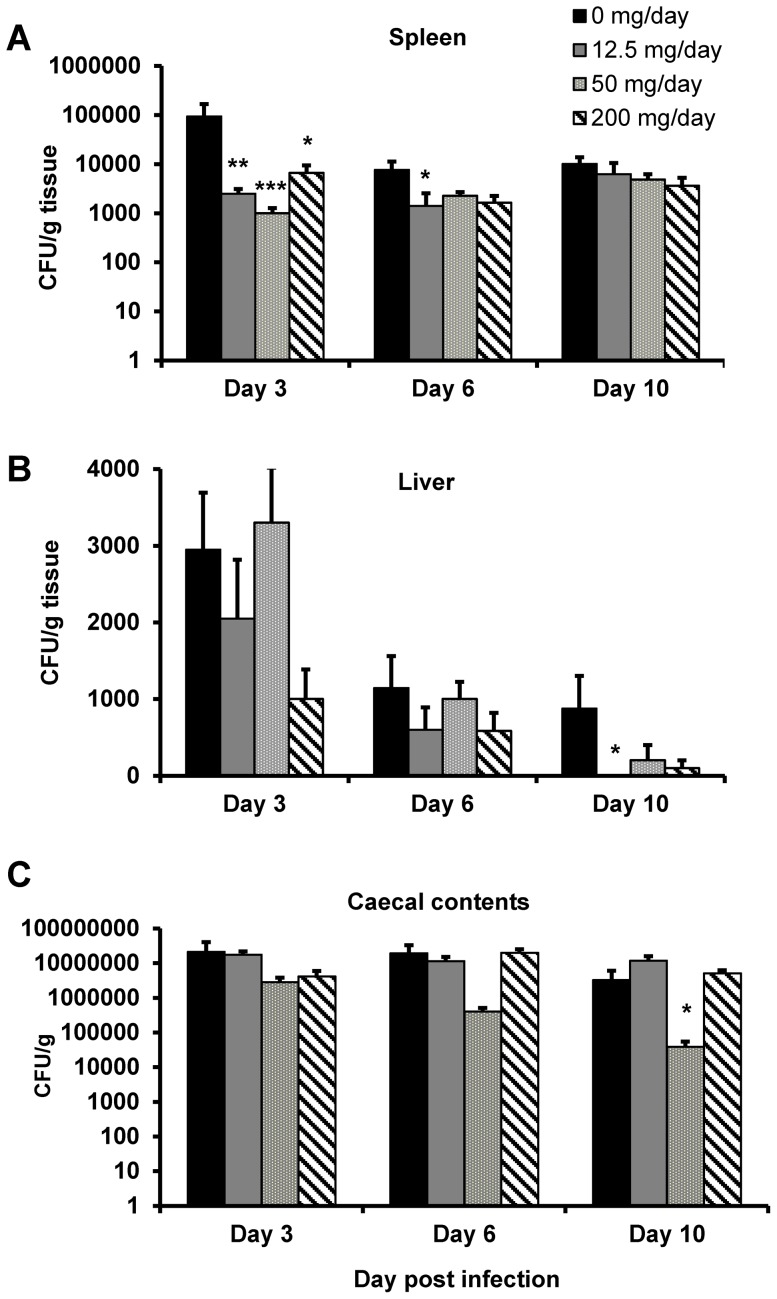
Dietary supplementation with soluble plantain NSP reduces chick salmonellosis in vivo.
(A) Following infection of 8 day-old inbred specified pathogen-free White Leghorn Line 0 chicks with S. Typhimurium 4/74, soluble plantain NSP supplementation of a commercial pellet feed significantly reduced bacterial numbers found in the spleen 3 d post-infection. (B) Supplementation with soluble plantain NSP had little significant effect on presence of S. Typhimurium CFU cultured from the liver, excepting at 10 d post infection. (C) Total CFU observed within the caecal lumen were relatively unchanged at all doses of plantain NSP supplementation compared to birds fed a control diet. Significant differences from control (non-supplemented NSP) diet, * P<0.05; ** P<0.01; *** P<0.0001 Kruskal-Wallis (N = 4–7 birds, n = 2 replicates).